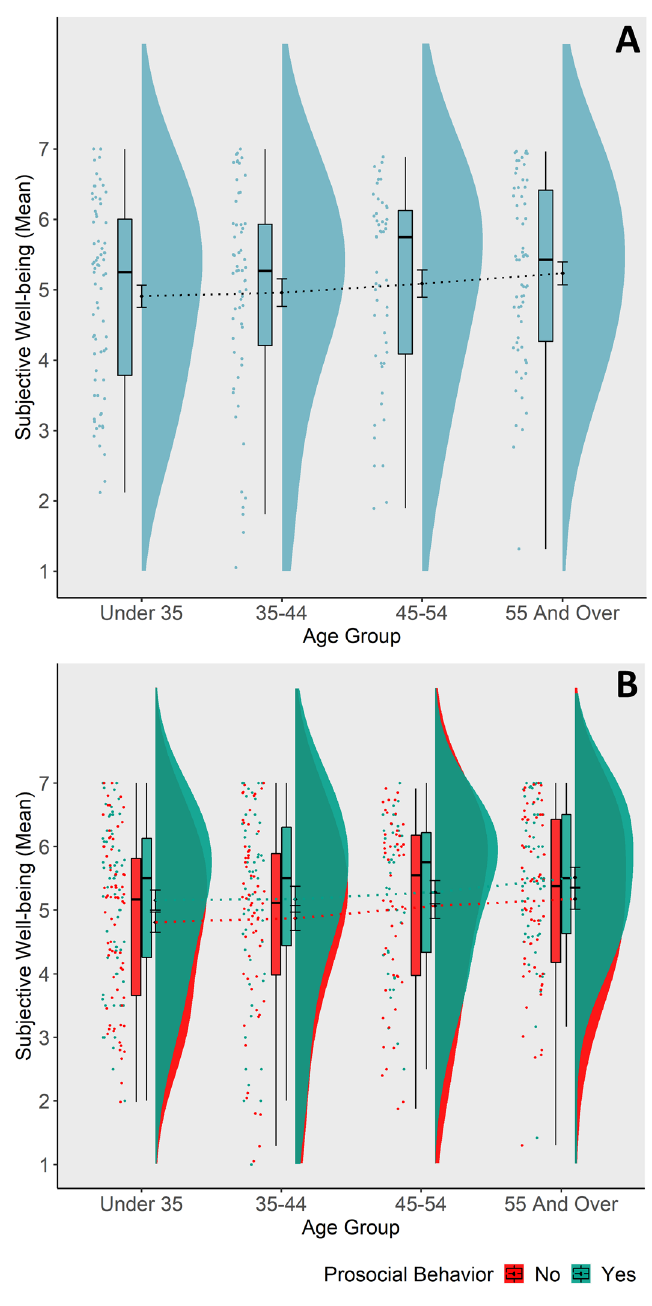
Figure 4. Daily well-being. ( A ) Adult age differences in subjective well-being. No significant association between age and well-being. ( B ) Within-subject effect of prosocial behavior x age on well-being. Positive association between well-being and acting prosocially, irrespective of participants’ age. Stronger association of a prosocial act with wellbeing in younger